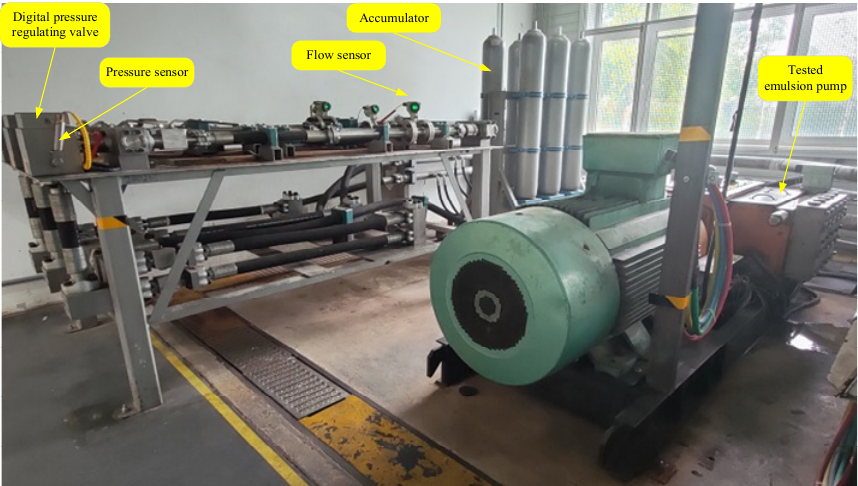
Figure 11. Emulsion pump test platform.